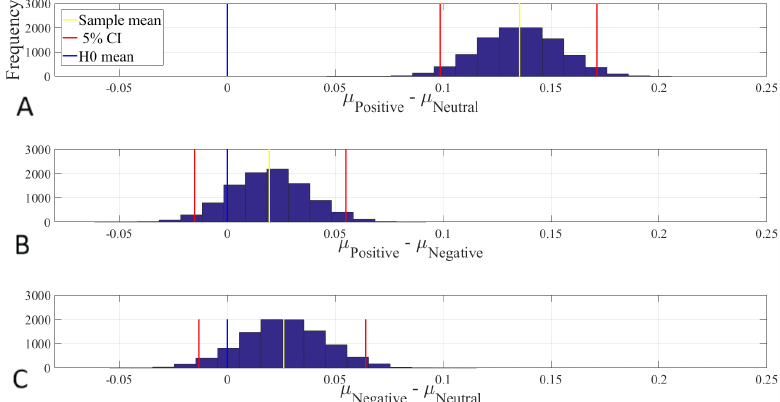
Figure A22. Paired two-sample bootstrap test of significance (10,000 simulation runs) at 95.0% CI associated with the participants’ PE7s (i.e., 62 PE7s associated with 62 EEG channels of a participant, per affect). Compared pairs of mental states are ( A ) positive versus neutral, ( B ) positive versus negative, and ( C ) negative versus neutral. X-axis: difference between average values of two affective states (e.g., positive versus negative). Blue line: non-significant difference between MSE1s of two different affective states. Red lines: 95.0% confidence interval boundaries. Yellow line: average two affetective states’ mean differences over 10,000